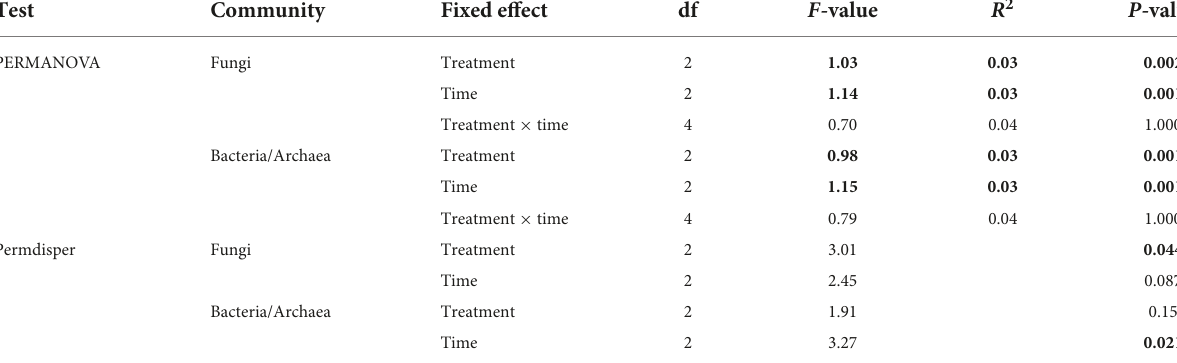
TABLE 2 Results from a permutational analysis of variance (PERMANOVA) and betadisper test with garlic mustard treatment, time, and their interaction (PERMANOVA only) as fixed effects and samples stratified by site (forest).